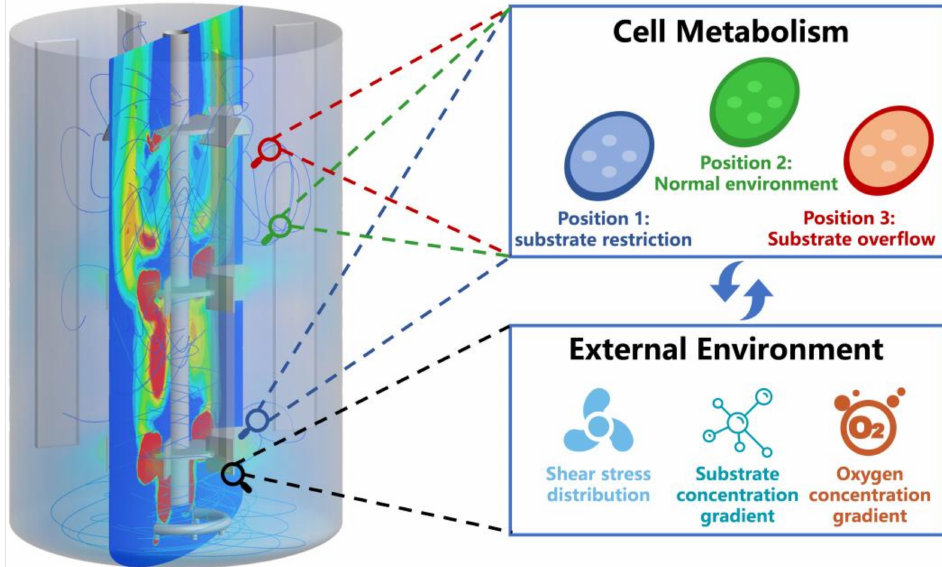
Figure 4. Schematic of metabolic models and computational fluid dynamics